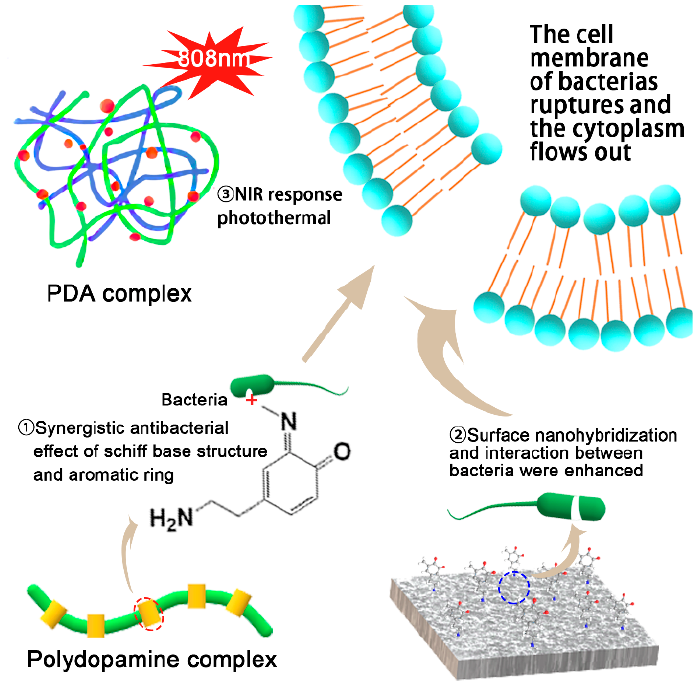
Figure 4. Antibacterial mechanisms of PDA complex. By summarizing the bacteriostatic rate data of some PDA complex, it was found that the inhibition rate of the complex was higher under NIR radiation and the complex was generally more effective against Gram-negative bacteria (Table 1). This is because the high temperature produced by NIR can accelerate the death of bacteria. However, Staphylococcus aureus ( S. aureus ) and other Gram-positive bacteria are generally more heat- resistant than Gram-negative bacteria such as Escherichia coli ( E. coli ). The former has a thick peptidoglycan layer (20–80 nm) composed of amino acids, surface proteins, teichoic acid and lipids. Gram-negative bacteria lack these structures. Lack of outer membrane promotes the penetration of the surrounding environment through the peptidoglycan layer [67]. Table 1. NIR heating temperatures and bacteriostatic rates of various materials containing